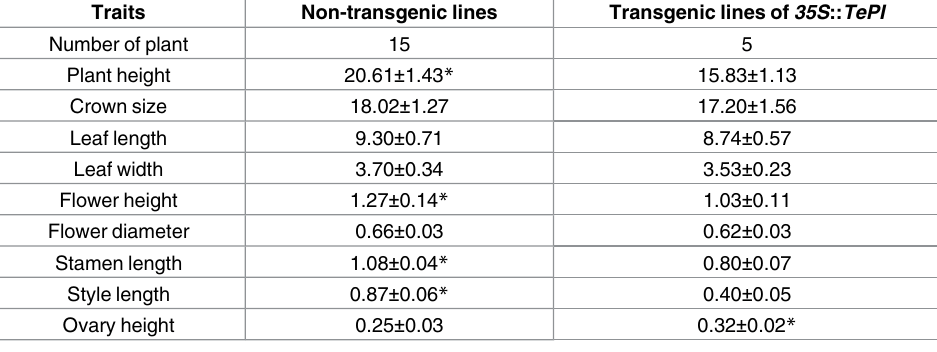
Table 1. Phenotypic analysis of non-transgenic and transgenic N . rotundifolia lines of 35S :: TePI unit: cm. Traits Non-transgenic